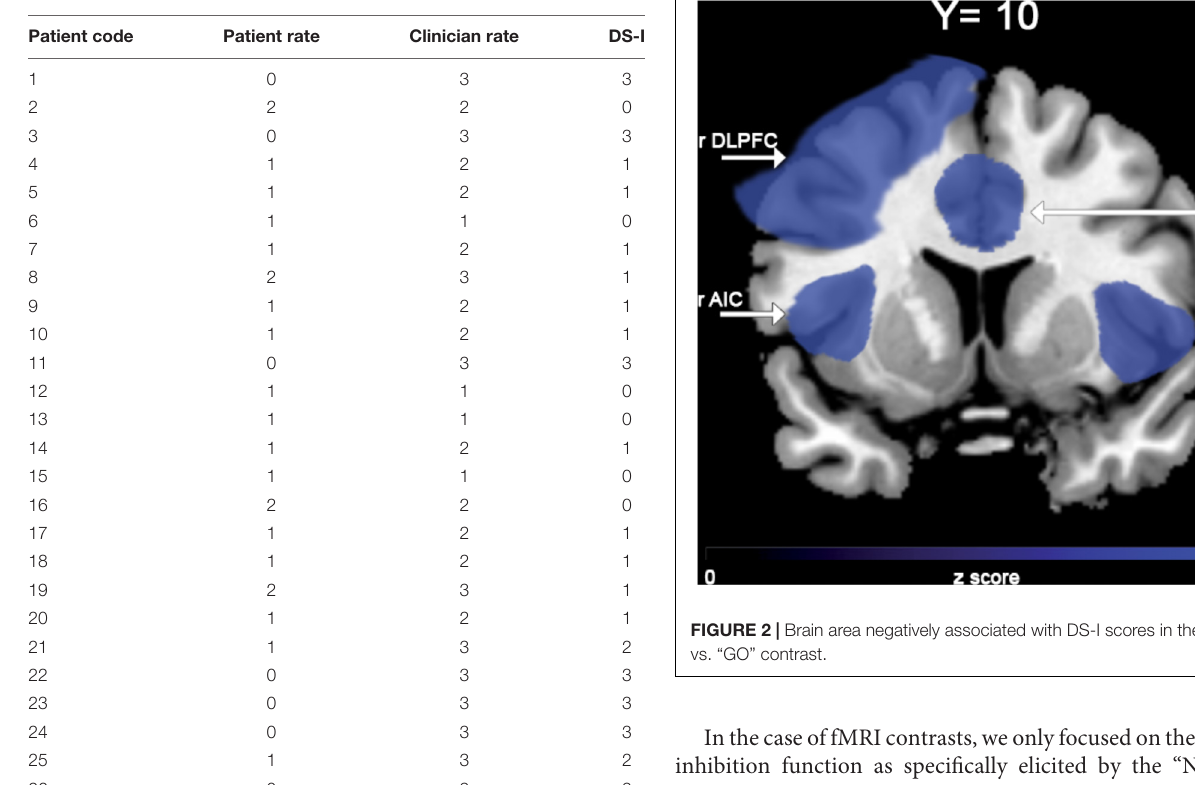
TABLE 3 | DRSA assessment as measured by the DS-I scale.